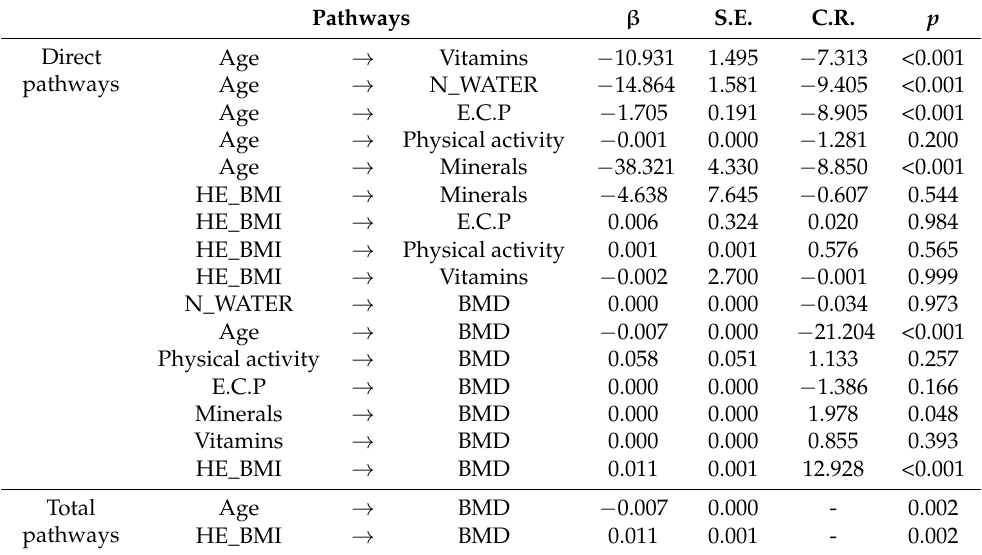
Table 7. Results of direct and total pathways in postmenopausal women with bone mineral density.